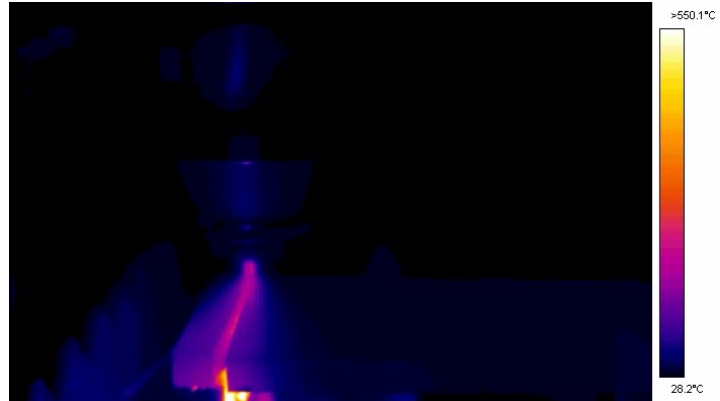
Figure 3. IR image of the cutting